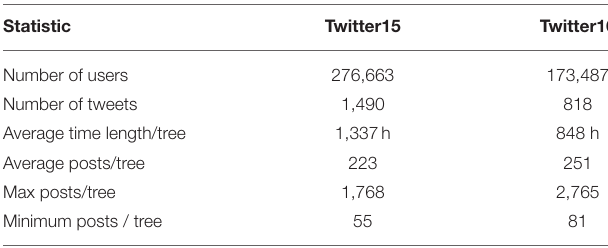
TABLE 1 | Statistics of Twitter15 and Twitter16 datasets (Ma et al., 2017).